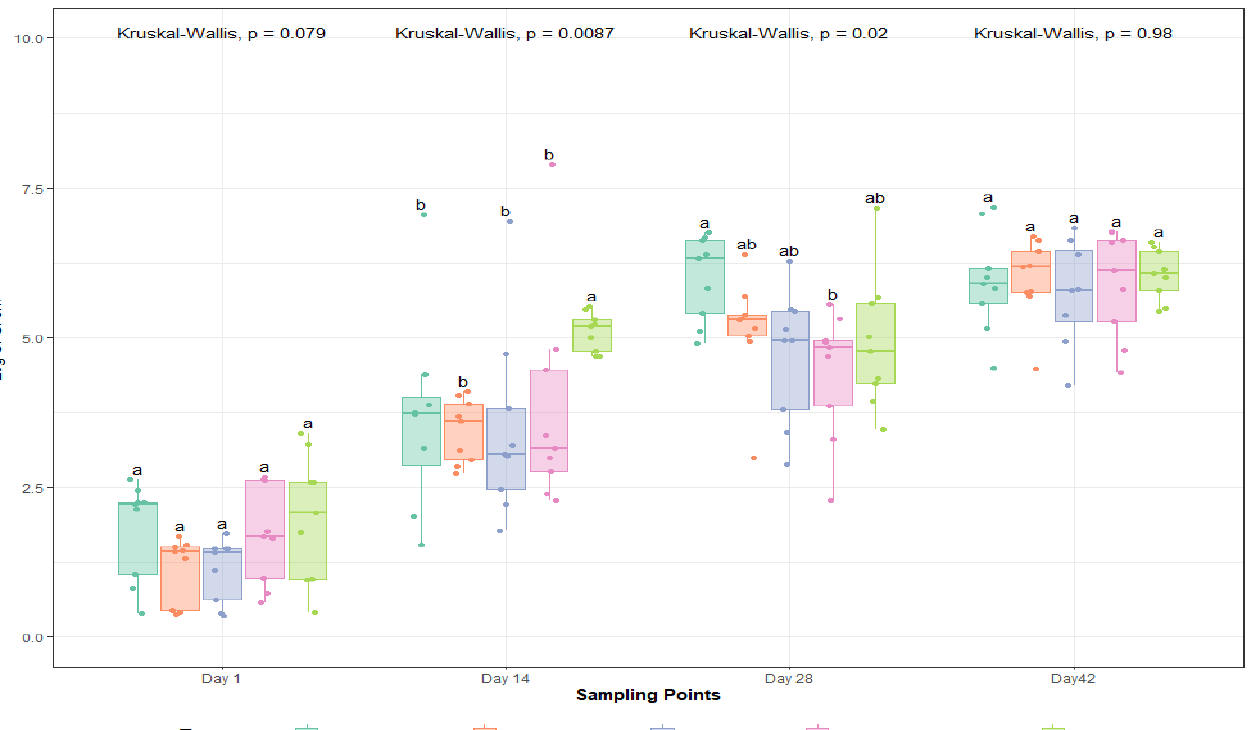
Figure 3. Mesophilic aerobic plate counts (Log CFU/cm 2 ) after 1, 14, 28, and 42 days of dark storage time on pork loin sections ( n = 45 per dark storage time). In each boxplot, the horizontal line crossing the box represents the median, the bottom and top of the box are the lower and upper quartiles, the vertical top line represents the upper interquartile range, and the vertical bottom line represents the lower interquartile range. For each sampling point day, boxes with different letters a,b are significantly different according to Kruskal–Wallis analysis followed by pairwise comparison Wilcoxon’s test at p < 0.05. The points represent the actual data points. Active ingredients: Bovibrom = 1,3-Dibromo-5,5-dimenthylhydantoin; Fit Fresh = chlorine dioxide; Washing Solution = rhamnolipid.